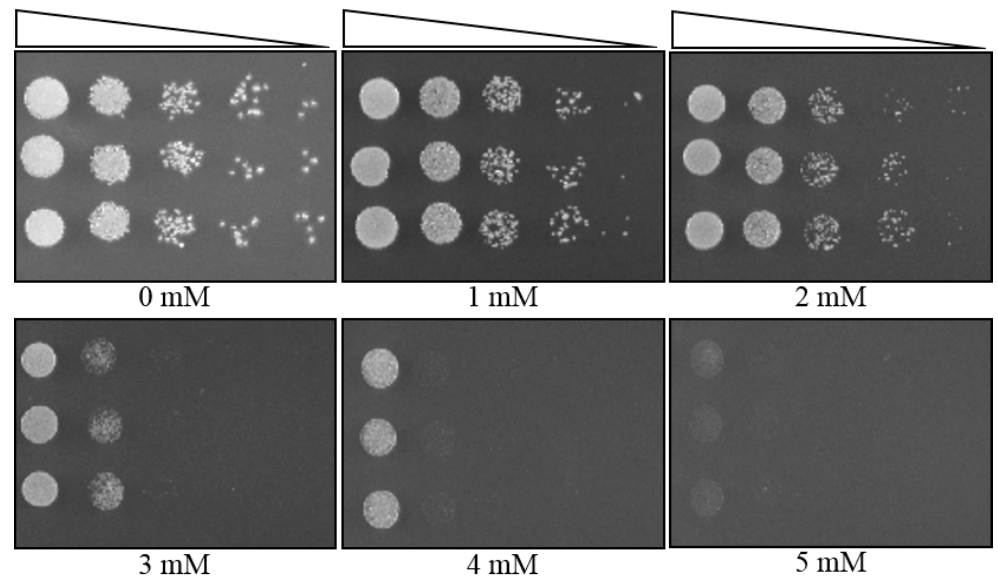
Figure 4. The MIC determination of yeast strain SRS-4-S, using a plate MIC method. All three lanes represent SRS-4-S in triplicate. The steps were followed as described in Figure 1A. Plate images were taken after two days of incubation, at 30 °C.